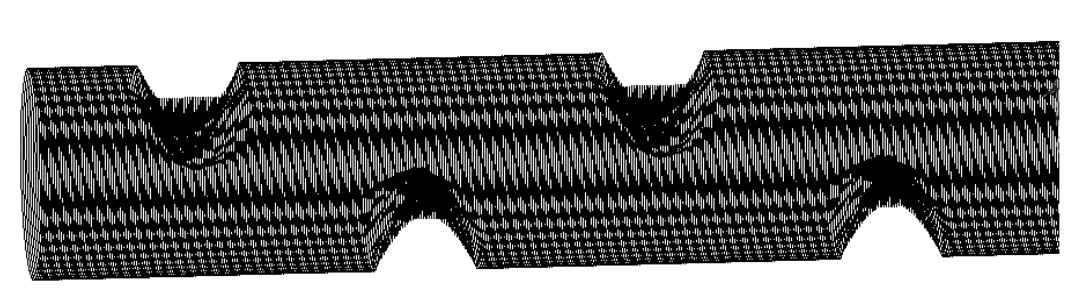
Figure 3. Locations of pipe deformations over the pipe length (pipe length = 0.5 m, diameter = 100